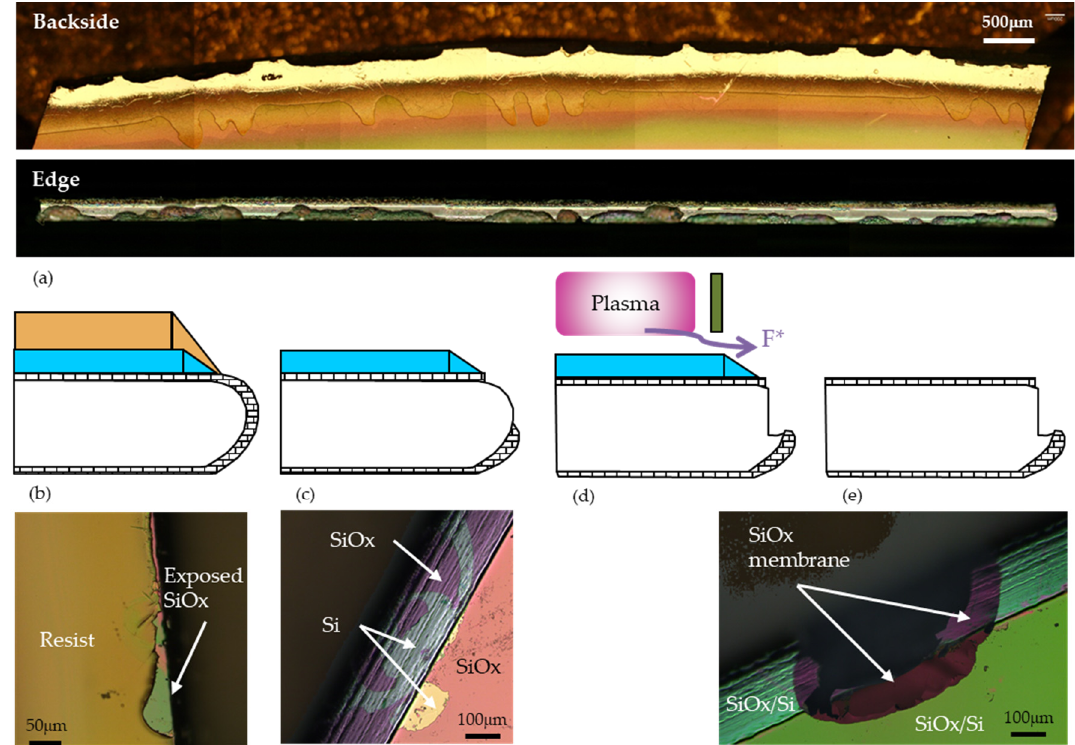
Figure 8. ( a ) Edge damage due to Deep Reactive Ion Etching (DRIE) observed from the etched side (backside) and the edge of the wafer; sequence of steps leading to the observed damage: ( b ) the resist does not cover the wafer surface to the edge, ( c ) silicon oxide is etched during definition of the DRIE mask, ( d ) exposed silicon is etched by F* radicals leaking form the plasma, and ( e ) final results: damaged